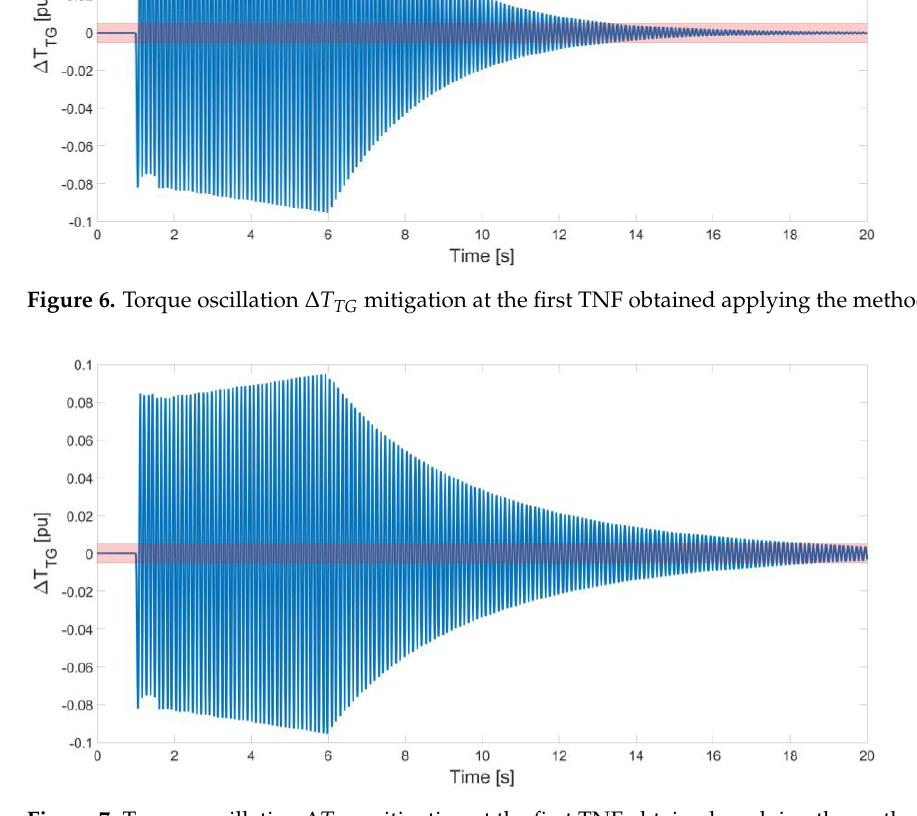
Figure 7. Torque oscillation Δ T TG mitigation at the first TNF obtained applying the method [17].